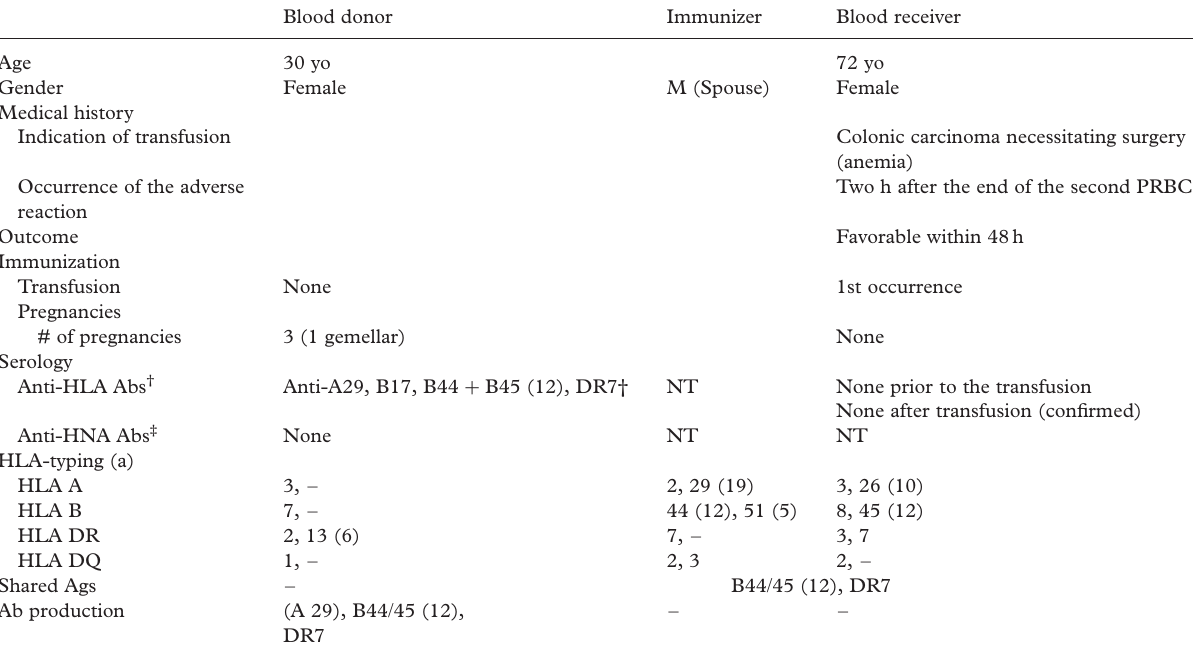
Table II. Case report 2 on the occurrence of TRALI after transfusion of packed red blood